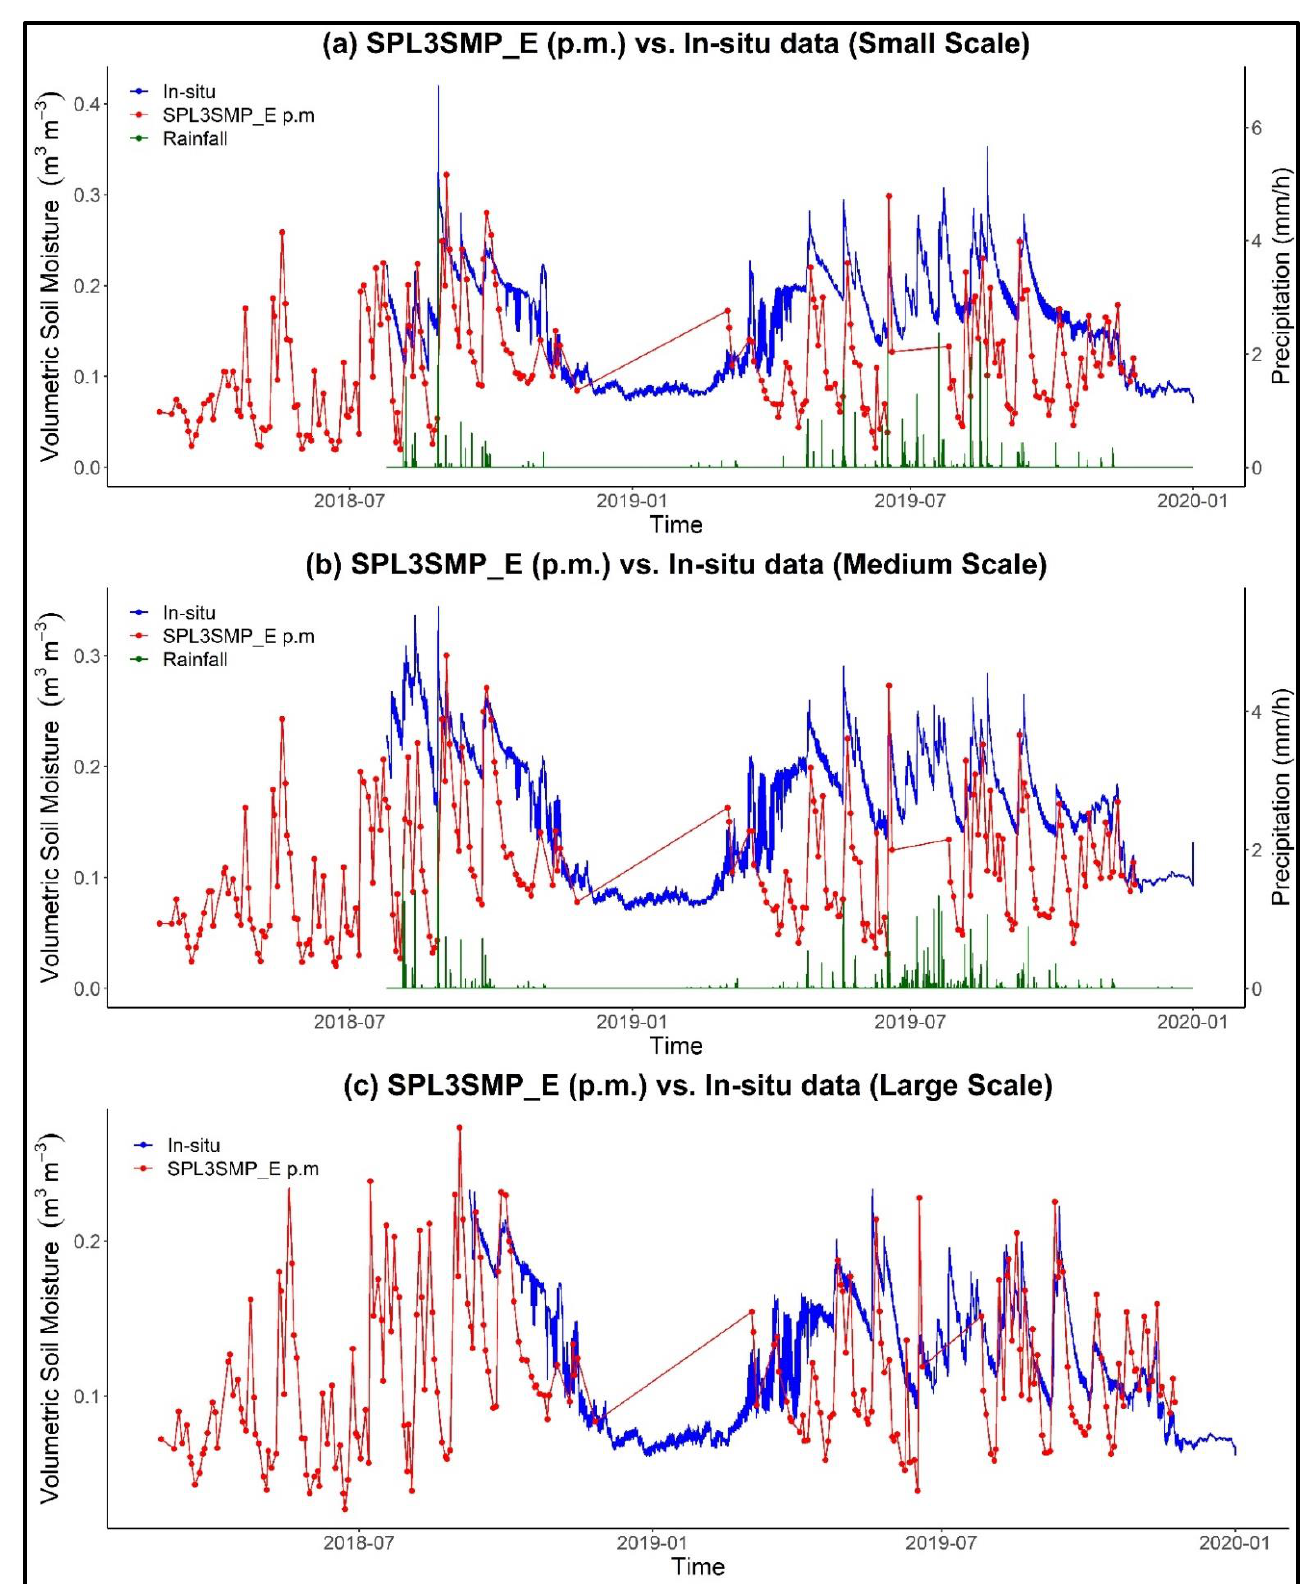
Figure 7. Comparison of SPL3SMP E (p.m.) SM and station averaged in situ data (hourly composite of SSM) at different spatial locations, ( a ) S-scale stations, ( b ) M-scale stations, ( c ) L-scale stations.